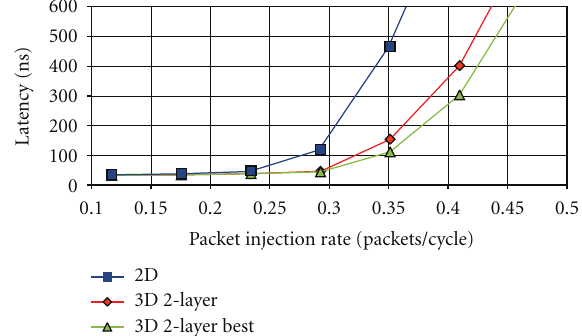
Figure 19: Latency comparison for 2D and 2-layer implementa- tions of hp .